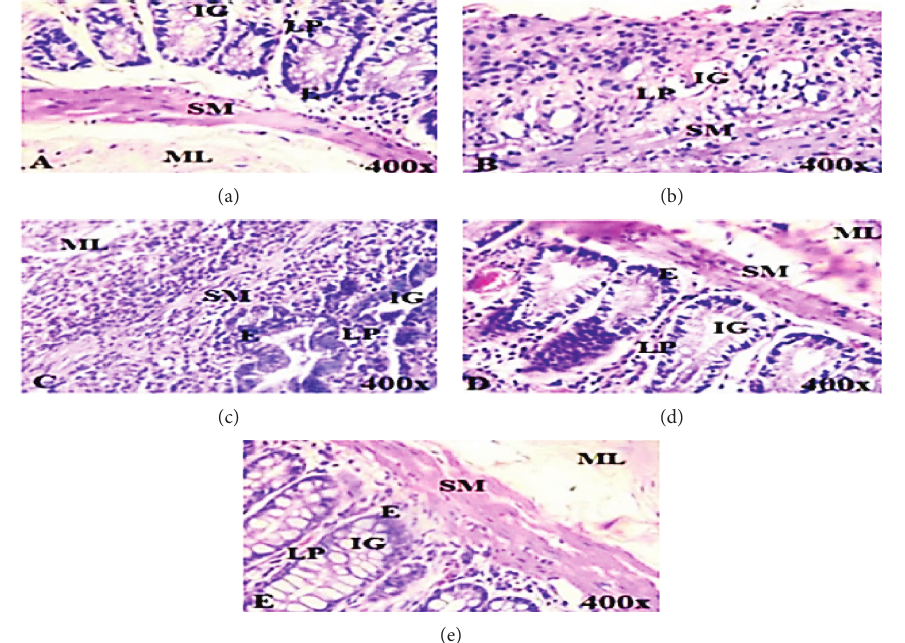
Figure 10: Photomicrographs of the na¨ıve control (a) and croton oil-induced inflammation in the rectoanal tissues in rats (b–e). (a) Histology of the rectoanal tissue of the na¨ıve control group (G1). (b) Histology of the disease control group (G2). (c) Histology of the vehicle (bland base treatment) treatment group (G3). (d) Histology of the diclofenac treatment group (G4) (15mg/kg bodyweight diclofenac suppository, delivered i.r.). (e) Alum “Aw” suppository treatment group (100mg/kg bodyweight delivered intrarectally (i.r.)). IG: intestinal gland; LP: lamina propria; E: epithelium; SM: submucosa; ML: muscularis